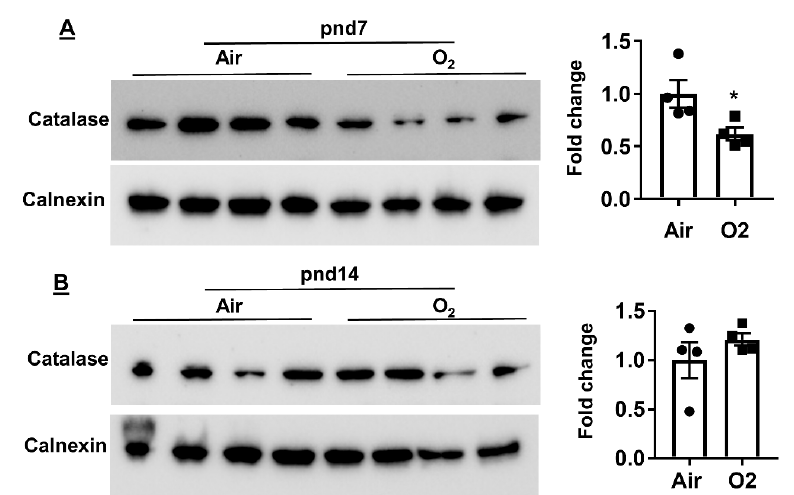
Figure 11. Protein levels of lung catalase in mice exposed to hyperoxia as neonates. C57BL/6J mice ( < 12 h old) were exposed to hyperoxia ( > 95% O 2 ) or room air (21% O 2 ) for 3 days, and were allowed to recover in room air until pnd7 or pnd14. Western blot was performed to determine the levels of catalase in lungs at both pnd7 ( A ) and pnd14 ( B ). Data are expressed as mean ± SEM. n = 4. * p < 0.05 vs.